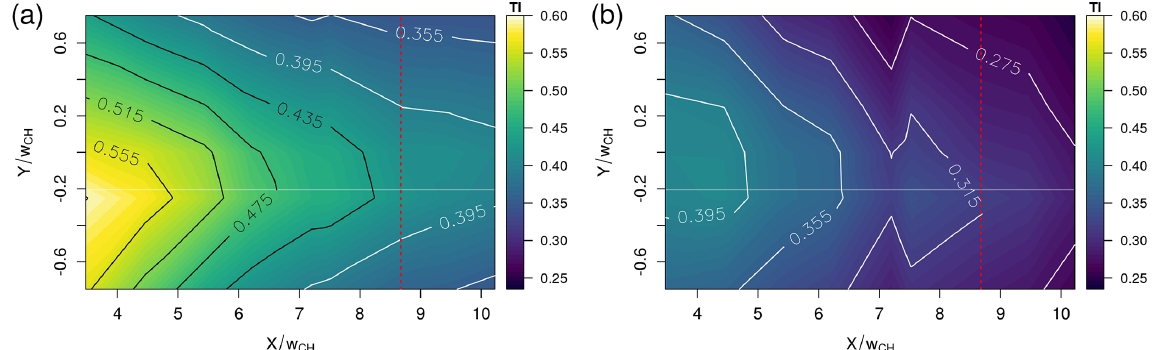
= 0 . 4Hz. The red = 0 . 04Hz and (b) f CH 2 1